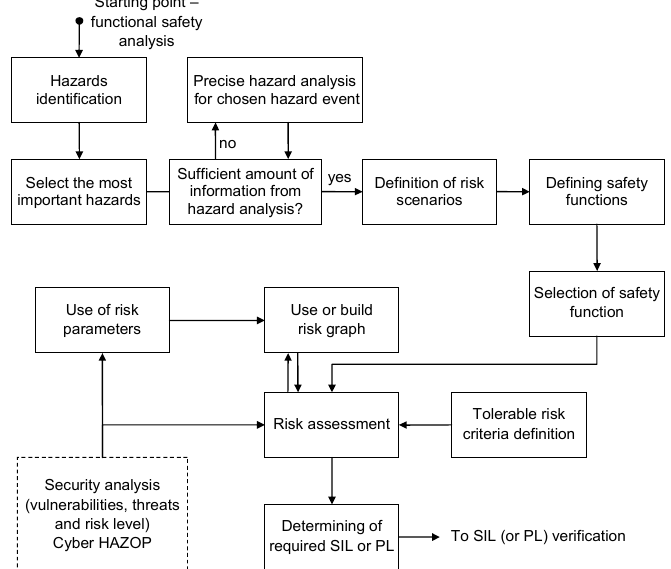
Figure 9. The procedure of SIL or PL determining the cybersecurity